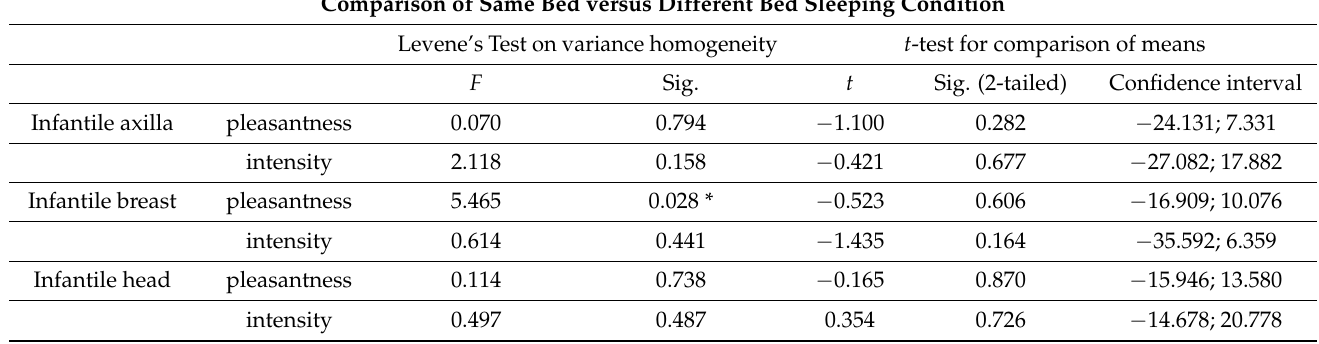
Table 4. Levene’s and t -statistic for the comparison of means. * p < 0,05. The t -statistics listed here correspond to the result of the Levene’s test, i.e., if the Levene’s test was significant, the t -statistic for inhomogeneous variances was chosen. Comparison of Same Bed versus Different Bed Sleeping Condition Levene’s Test on variance homogeneity t -test for comparison of means F Sig. t Sig. (2-tailed) Confidence interval Infantile axilla pleasantness